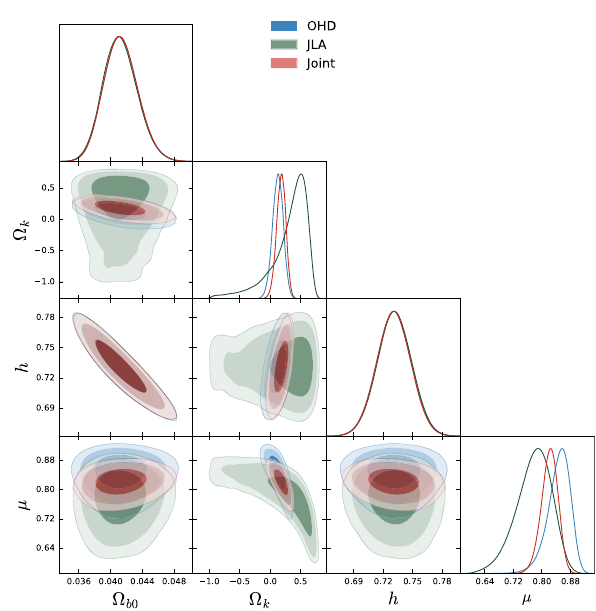
Fig. 5 1D marginalized posterior distributions and the 2D 68%, 95%, 99 . 7% confidence levels for the Ω b 0 , Ω k , h , and μ parameters for a non-flat